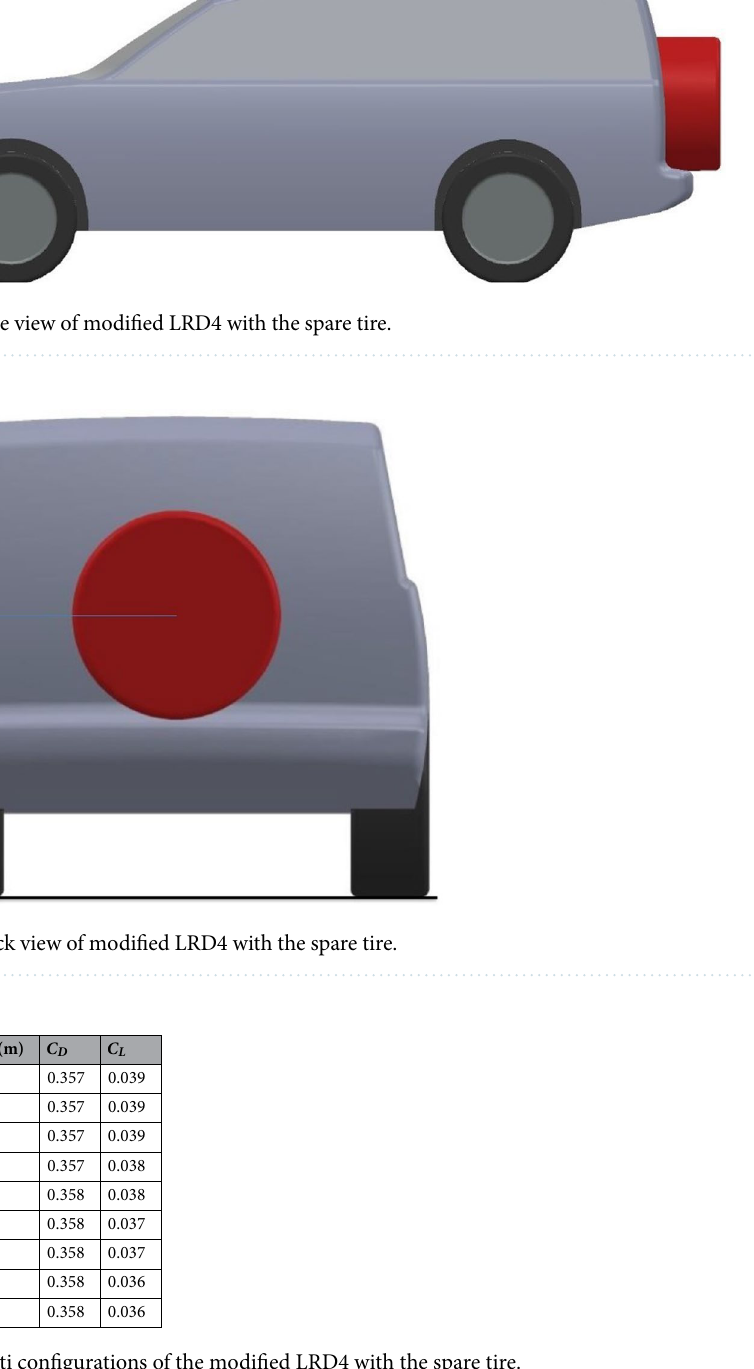
Table 4. Multi configurations of the modified LRD4 with the spare